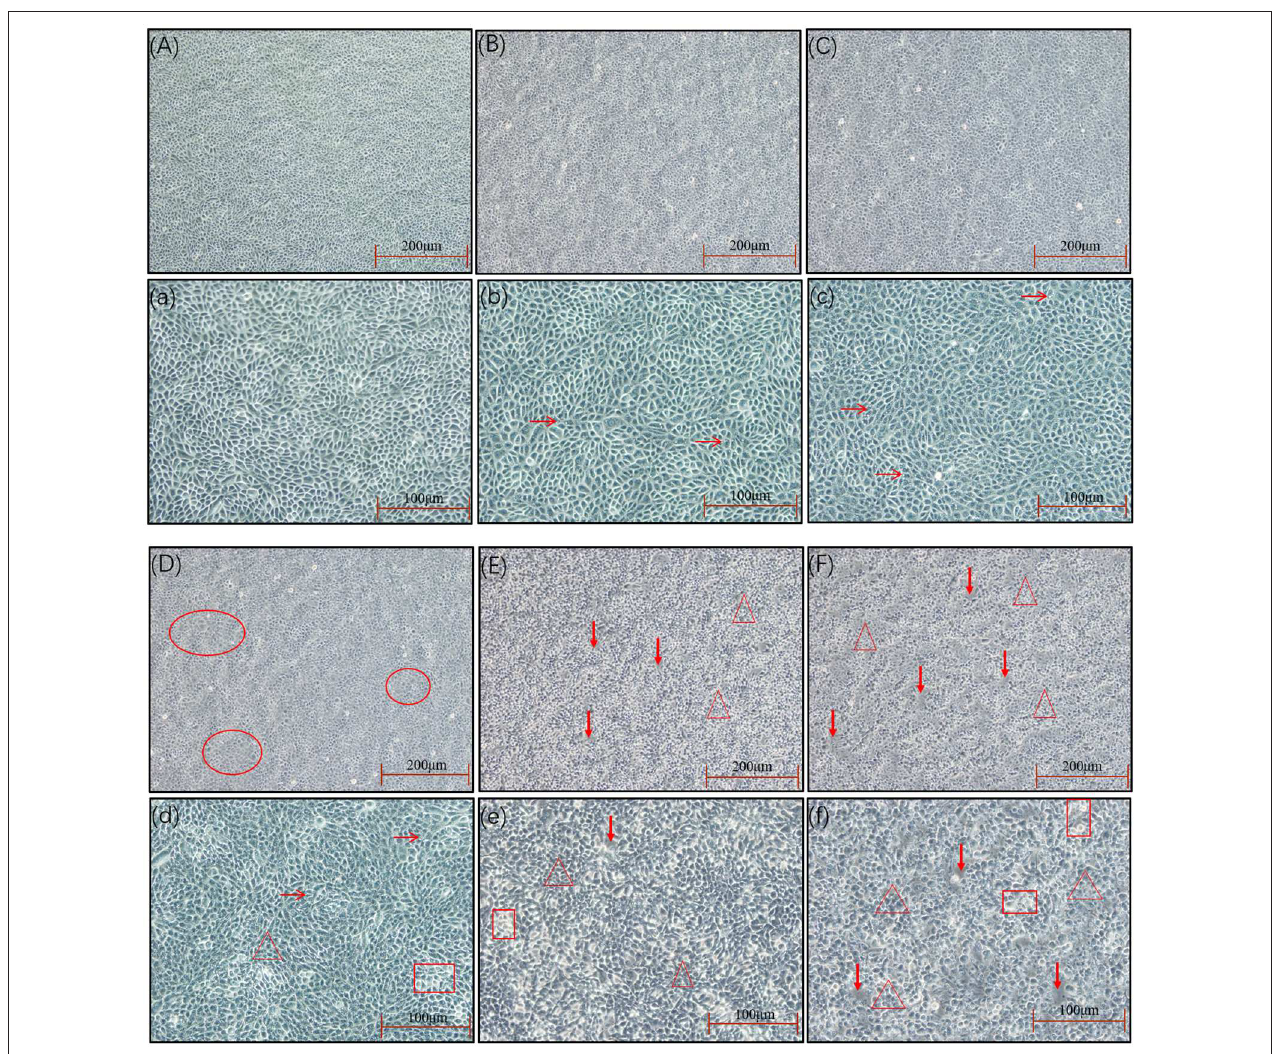
FIGURE 5 | The cell morphology at different MOIs. The SEECs were non-treated or treated with five different MOIs of E. coli for 3h, and cell morphologic changes were observed. (A,a) The cell morphology of normal SEECs. The cells were orbicular-ovate, with the edge clear and attached well. (B,b) The cell morphology at the MOI of 1:10. The cells showed no significant changes compared with normal SEECs, but with a few cell vacuolization (arrows). (C,c) The cell morphology at the MOI of 1:1. The cells showed no significant changes compared with normal SEECs, but the cells were not smooth and a few cell vacuolization (arrows) were observed. (D,d) The cell morphology at the MOI of 5:1. The cells in red circles in D become flattened with the edge blurring, and obvious cell vacuolization (arrows), transparence (rectangle), and cell shrinkage (triangle) were observed in d . (E,e ) The cell morphology at the MOI of 10:1. The cells were apparently shrunken (triangle), transparent (rectangle), and detached (bold arrows). (F,f) The cell morphology at the MOI of 100:1. Abundant cell shrinkage (triangle), transparence (rectangle), and detachment (bold arrows) were observed.